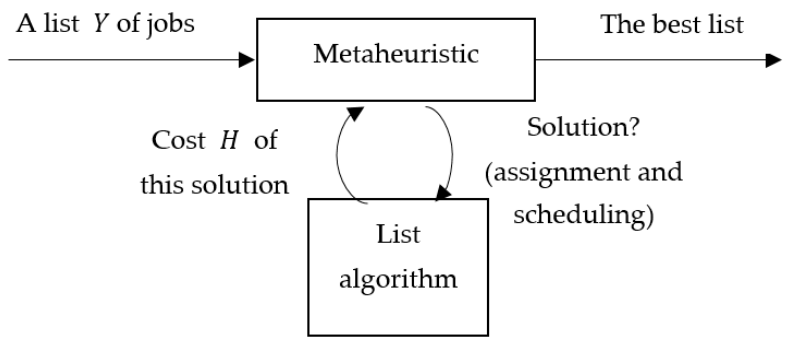
Figure 1. Hybridization metaheuristic—List algorithm.